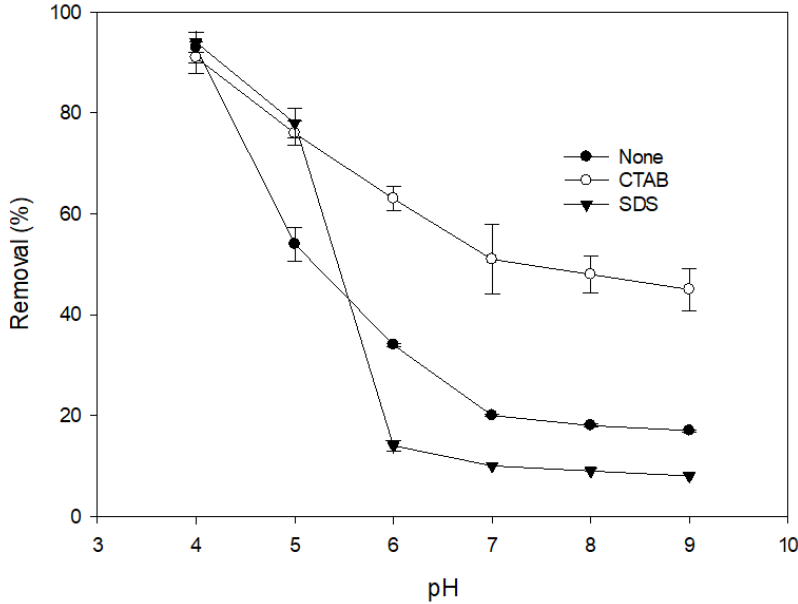
Figure 1. Effect of anionic and cationic surfactants on the removal efficiency of diclofenac (DIC) by manganese oxide. (reaction time = 1 day, (MnO 2 ) = 100 mg L -1 , initial DIC conc. = 100 µM, surfactant conc. = 100 µM, T = 25 °C).